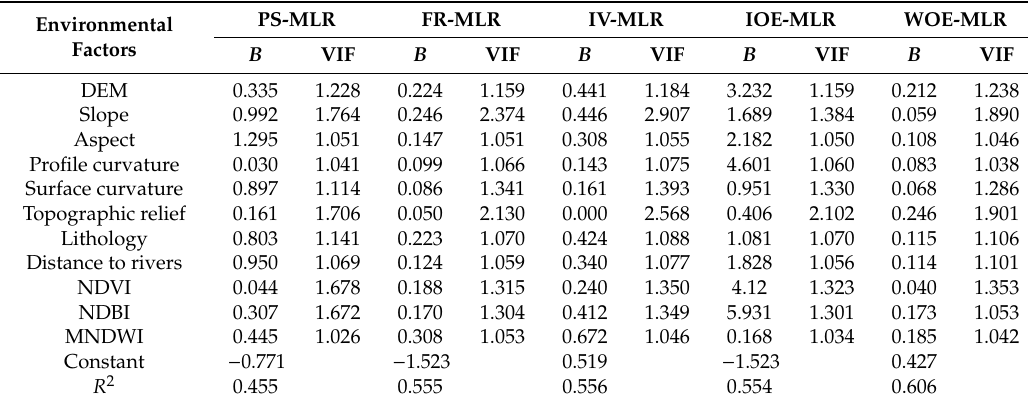
Table 3. Multiple linear regression coe ffi cients (B) and constant